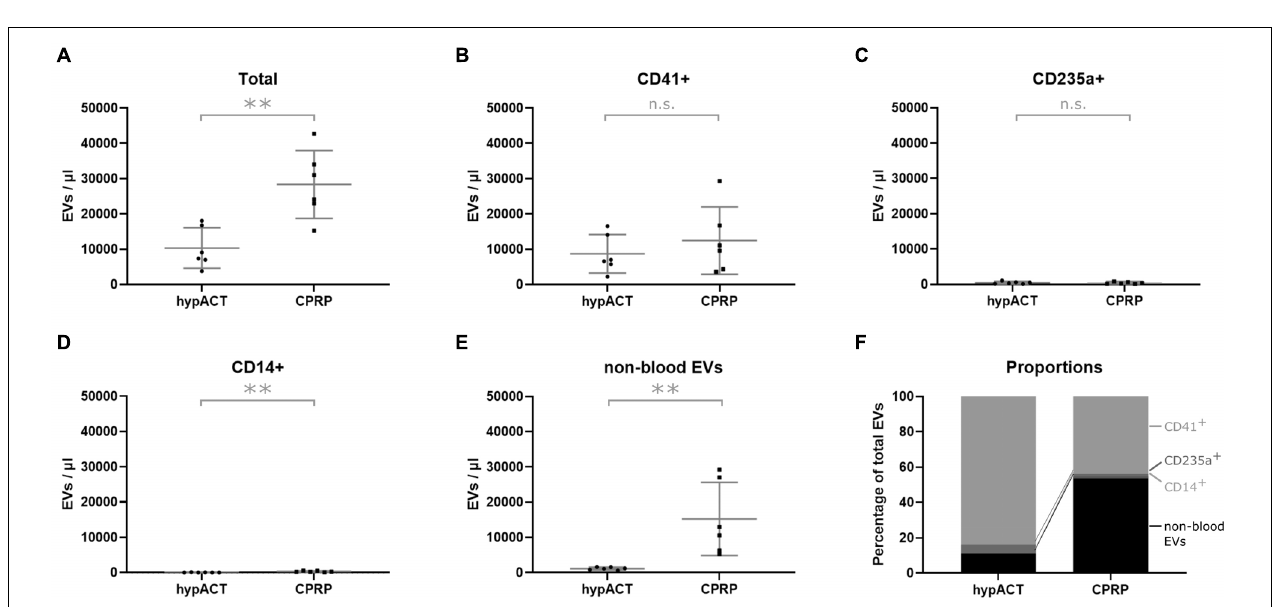
FIGURE 1 | (A) Overview of employed blood product production procedures for citrate-anticoagulated platelet-rich plasma (CPRP) and hyperacute serum (hypACT). Two rounds of centrifugation are involved and anticoagulant (citrate) is added for CPRP, whereas hypACT does not require anticoagulation and only one centrifugation step. (B) Profiles of residual blood cells in blood products. Data from n = 6 donors are shown with SD error bars. * p < 0.05; ** p < 0.01.